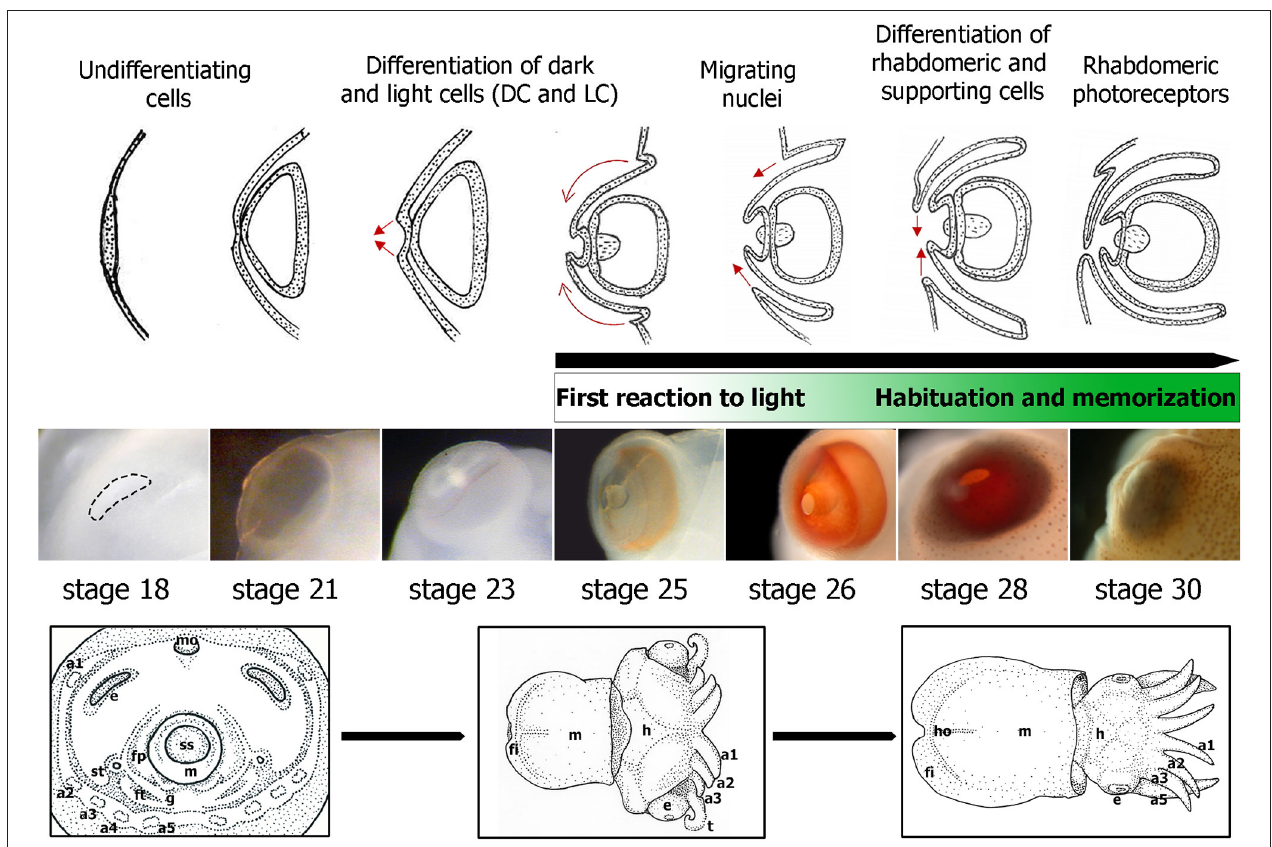
FIGURE 2 | Embryonic eye development in S. officinalis . From top to bottom: schematic drawings summarizing the eye morphogenesis between stages 18 and 30 (from Grassé, 1989) with indication of the differentiation of retina cell types based on Sepiella (Yamamoto, 1985). Green rectangle: first reaction and habituation to light from stage 25 and the memory process at late stages of development. Eye embryos’ photographs between stages 18 and 30. Down: drawings of three major phases of S. officinalis organogenesis. a1, a2, a3, a4, a5: arms 1 to 5; e: eye; fi: fin; fp: funnel pouch; ft: funnel tube; g: gill; h: head; ho: hoyle organ; m: mantle; mo: mouth; ss: shell sac; st: statocyste; t: